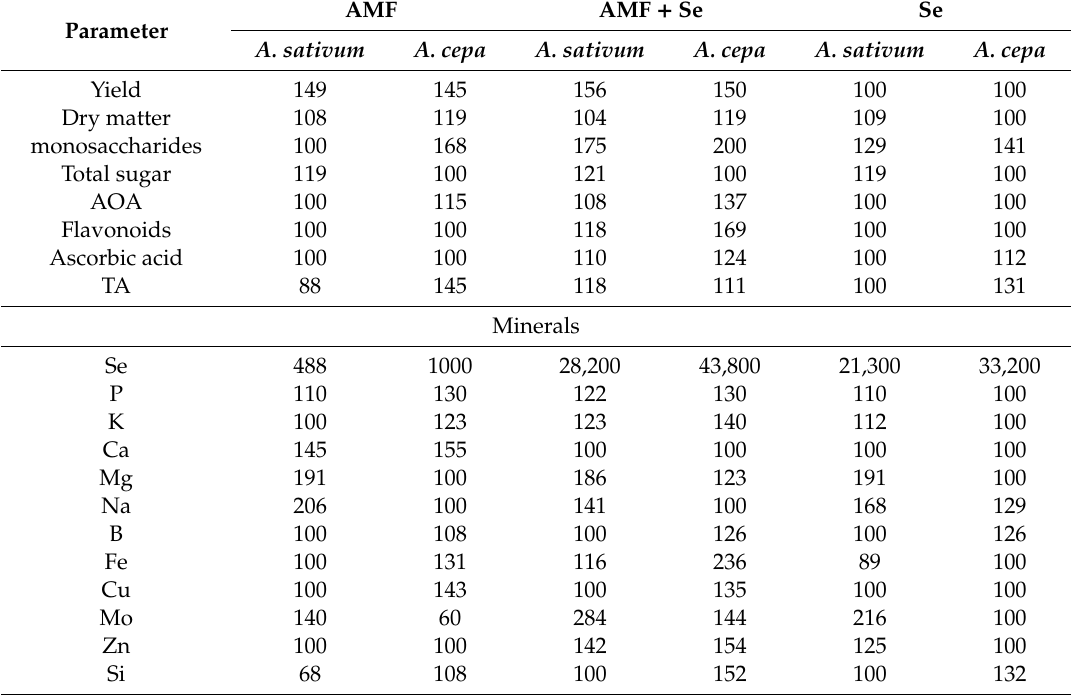
Table 2. E ff ect of AMF–Se application on biochemical parameters and elemental composition of